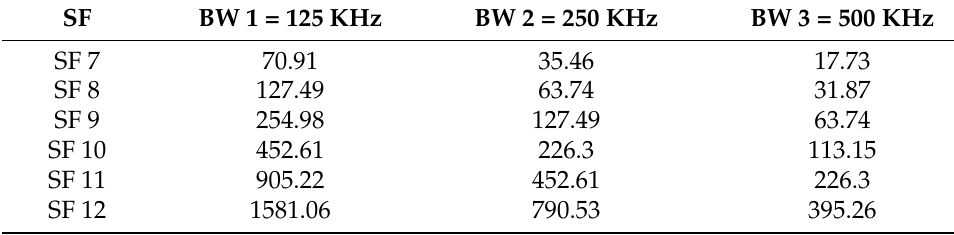
Table 10. ToA (ms) at CR 3.